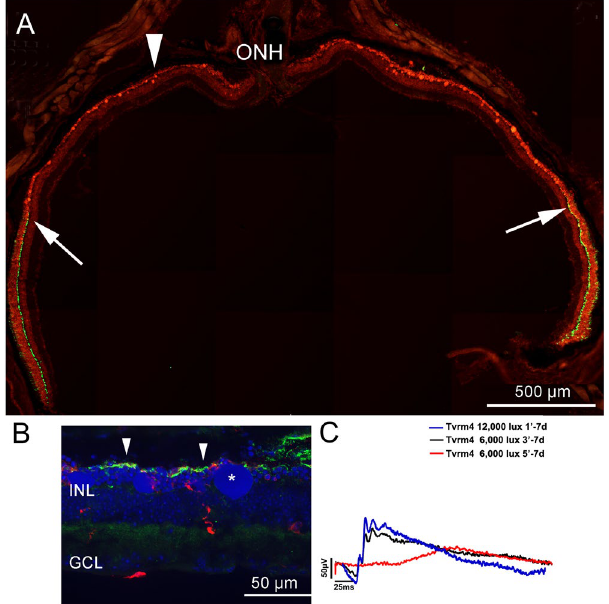
Figure 5. Effects of prolonged time exposure on retinal degeneration. ( A ) Equatorial retinal section obtained 7 days after 5 min exposure to 6,000 lux. ( A ) Cone arrestin (green) and ethidium staining (red) show that a large fraction of the retinal surface has undergone major photoreceptor loss. The ONL is reduced to 3–4 rows across approximately 80% of the retinal extension; cones are appear intact only close to the retinal margins, where the ONL has a normal thickness (arrows). ONH: optic nerve head. ( B ) High magnification of the arrowhead- indicated zone in ( A ). Rhodopsin staining (green) shows extreme reduction of rod outer segments. In this central area, cones (stained with arrestin, red) are rare and show aberrant morphologies. Hoechst DNA staining (blue) shows large apoptotic bodies in the outer retina (asterisk). This preparation conveniently recapitulates in space the degeneration progression typical of Tvrm4 mutants. ( C ) ERG traces obtained 7 days after exposure to inducing lights of different brightness and duration. The larger decrement of the retinal response is observed when exposure length increases from 3 to 5 minutes. Scotopic brightest flash: 83.7 cd * s/m 2